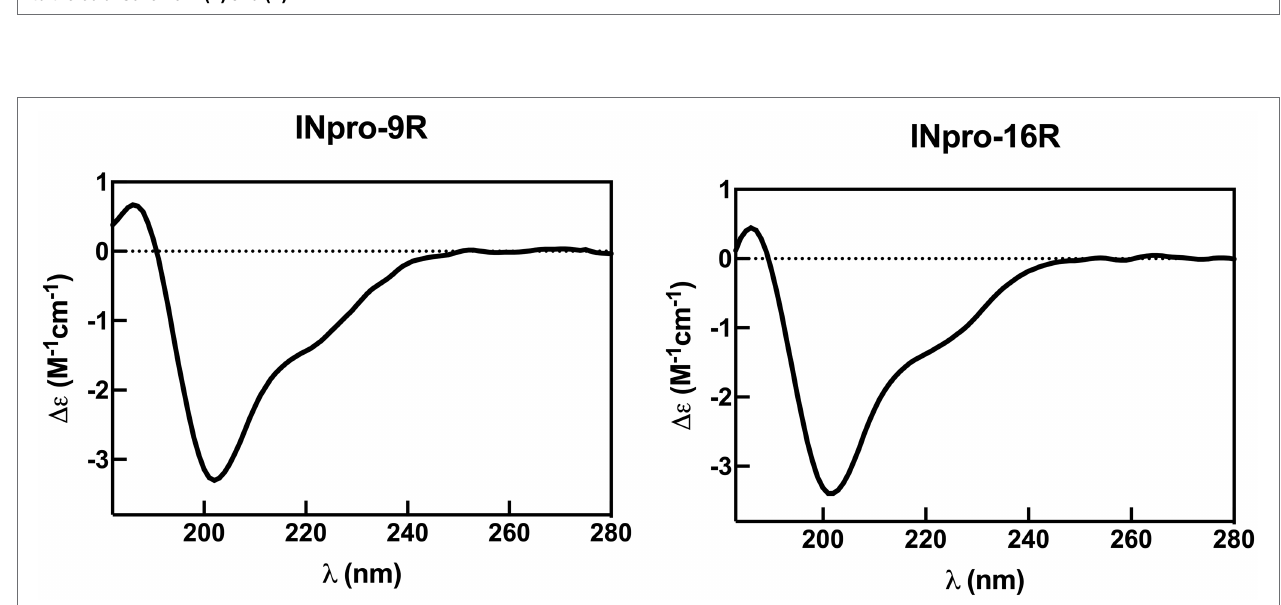
FIGURE 3 | Representative synchrotron radiation circular dichroism spectra for INpro-9R and INpro-16R. The spectra show beta strand/coil/turn structure features when deconvoluted with the SMP180 reference datasets at the DichroWeb portal. Data are shown for the wavelength range 182–280